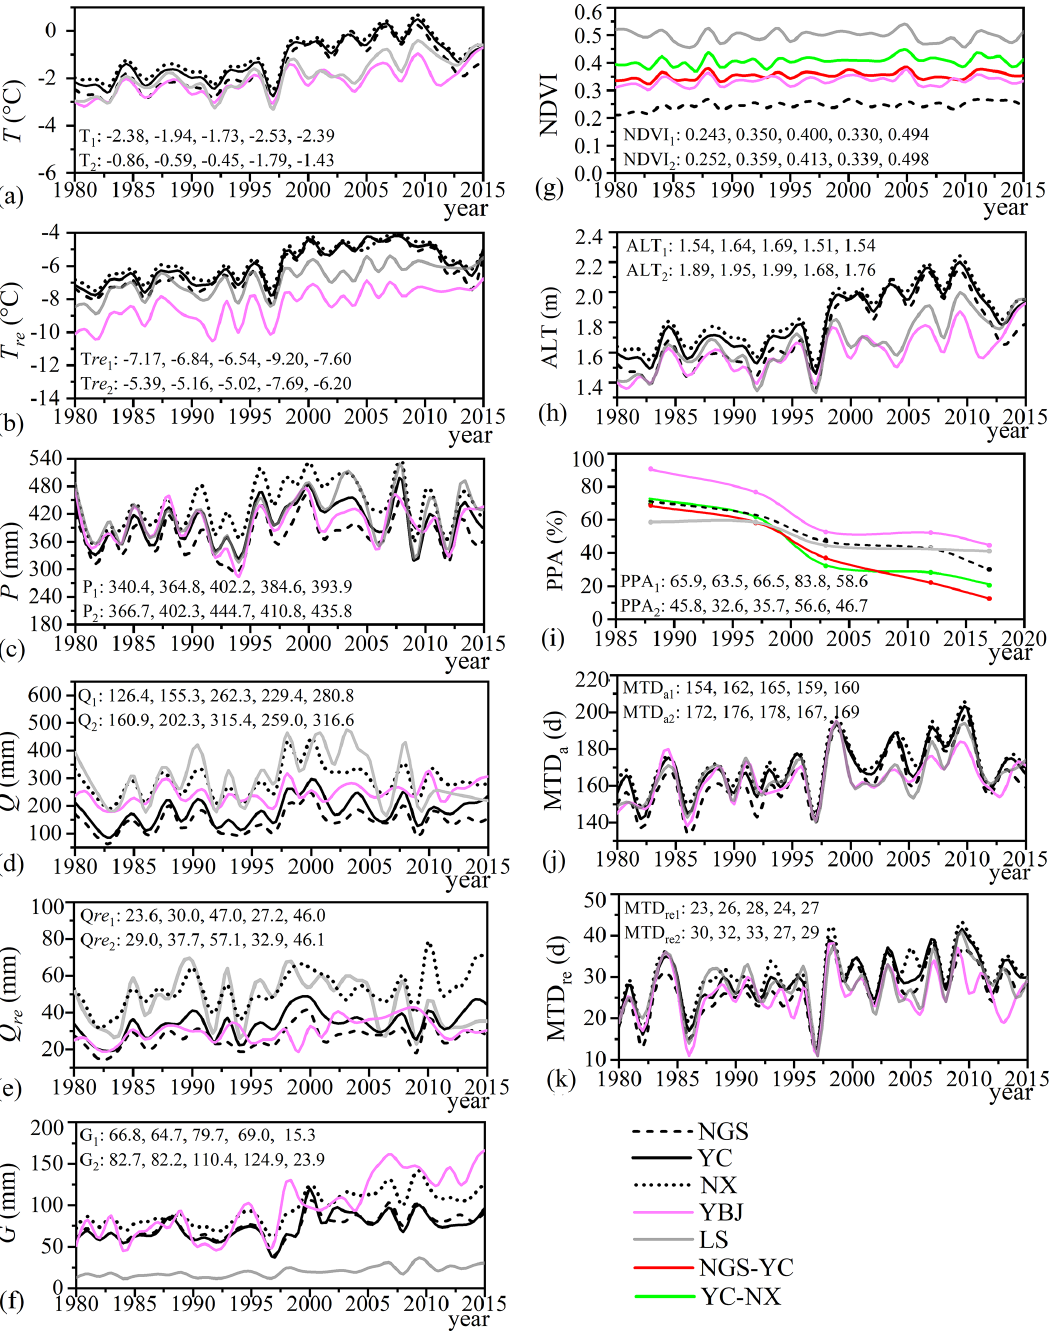
Figure 2. Variations in (a) annul mean temperature ( T ), (b) mean temperature in a recession period ( T re ), (c) precipitation ( P ), (d) dis- charge ( Q ), (e) discharge in a recession period ( Q re ), (f) glacier meltwater ( G ), (g) NDVI, (h) active layer thickness (ALT), (i) percentage of permafrost area (PPA), (j) the total number of days with the mean temperature above 0 ◦ C in a year (MTD a ), and (k) the total number of days with the mean temperature above 0 ◦ C for recession period (MTD re ) from 1980 to 2015 in the five subbasins. The subscripts 1 and 2 refer to the early period from 1980 to 1996 and the recent period from 1997 to 2015, respectively. NGS–YC refers to the area between the nested subbasins NGS and YC, and YC–NX is for the area of the nested subbasins YC and